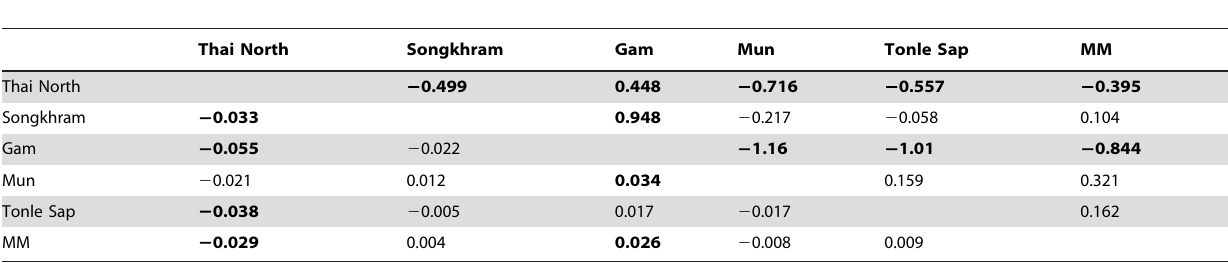
Significant differences are in bold. Values are average elemental molar ratios for regions in the row minus those in the column headings.